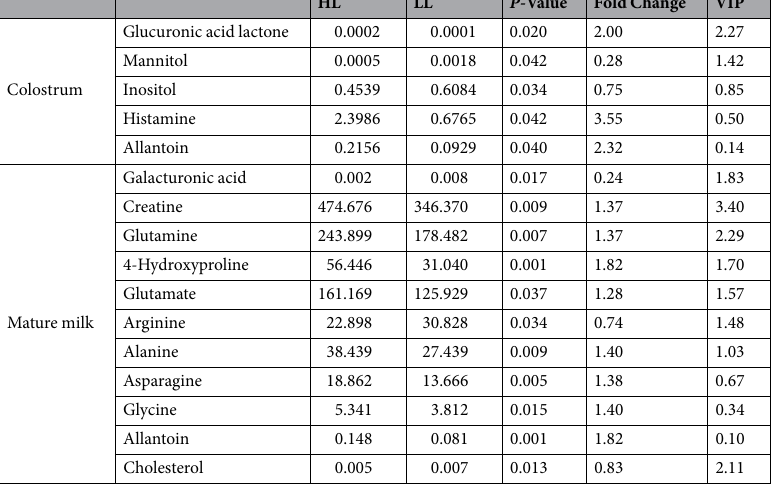
Table 3. Differential metabolites between HL and LL groups in colostrum or mature milk. HL: The peak area of target metabolites/internal standard in high lactation performance group; LL: The peak area of target metabolites in low lactation performance; P -value: The P -value of Student’s t-test; FC: fold change, peak area in HL group/ peak area in LL group. If FC > 1, it means the concentration of metabolites in HL group are higher than LL group, and vice versa. VIP: variable importance in projection (VIP) value calculated by PLS-DA assay.